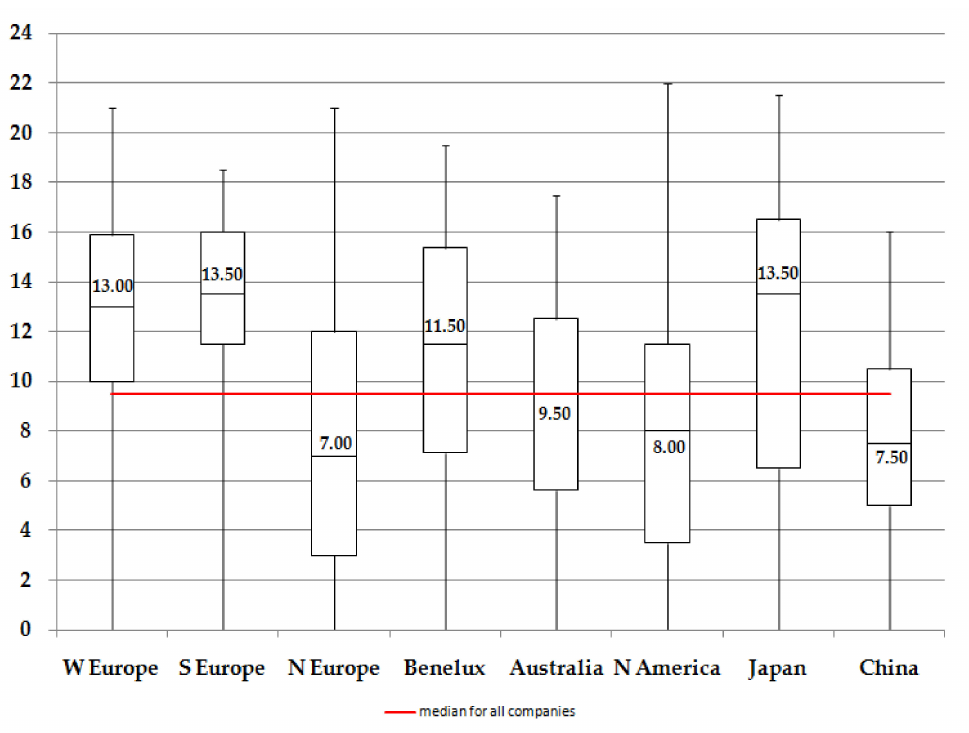
Figure 1. The distribution of overall grades in regions. Four regional groups achieved a higher median of overall rating than the entire population: Western Europe, Southern Europe, Benelux and Japan. The lowest median, but also the first quartile results, were recorded for Northern Europe. All regions had entities with an overall zero rating. The companies with the highest overall rating represented the North American group. As there is no single group with the highest values of extremes, median, first and third quartile at the same time, there is no clear leader among the regions.